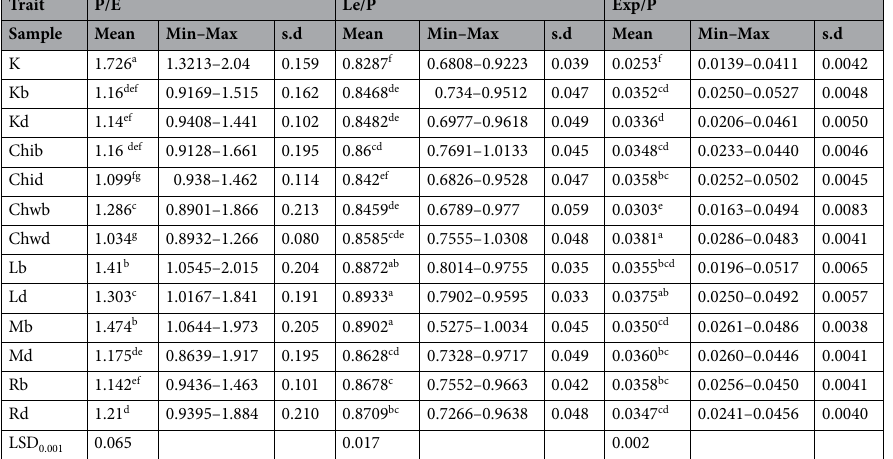
Table 3. Mean values and standard deviations for three ratios: P/E, Le/P and Exp/P, where P – length of polar axis, E – equatorial diameter, Le – length of ectocolpus, Exp – thickness of exine along the polar axis. Samples: K – trees without any treatment, Kd – trees with drilling, Kb – trees with bark incision as well as five different herbicides: Chi – Chikara, Chw – Chwastox, L – Logo, M – Mustang, R – Roundup and two methods of their application: d – drilling or b – incision. a–f In columns, means followed by the same letters are not significantly different.